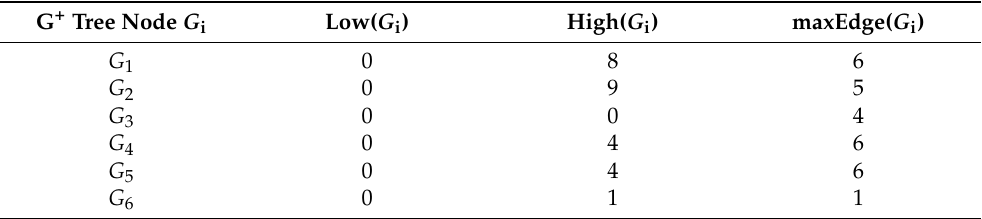
Table A11. Vertices and edges in the G + -tree nodes. G + Tree Nod G i Vertices in G i Edges in G i G 1 v 1 , v 2 , v 3 , v